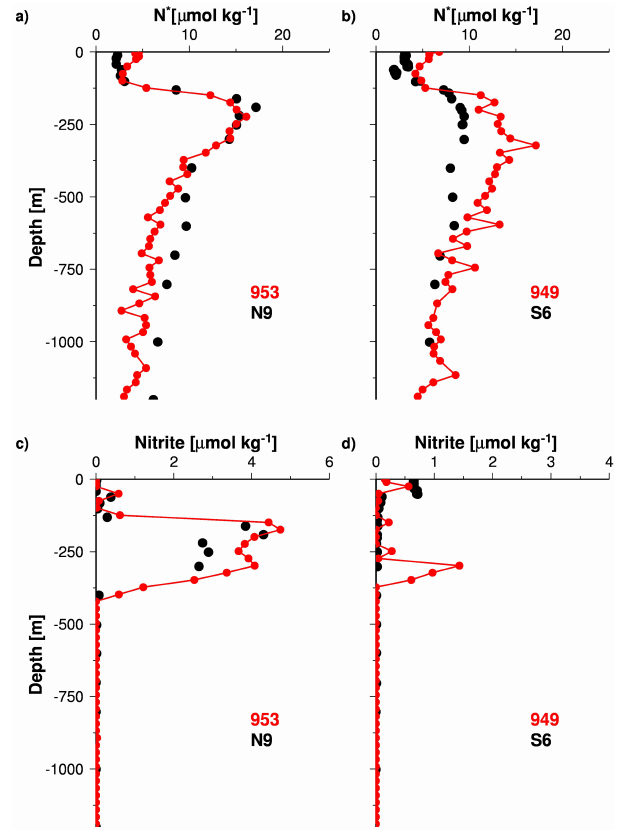
Figure 8. Profiles of NO − deficits expresses as N ∗ (a, b) and NO − 3 (c, d) obtained during the JGOFS late SW monsoon 1995 cruise ttn50 in the eastern (N9) and central (S6) Arabian Sea (black circles) and the M74/1b cruise at the same stations (red circles, stations 953 and 949).